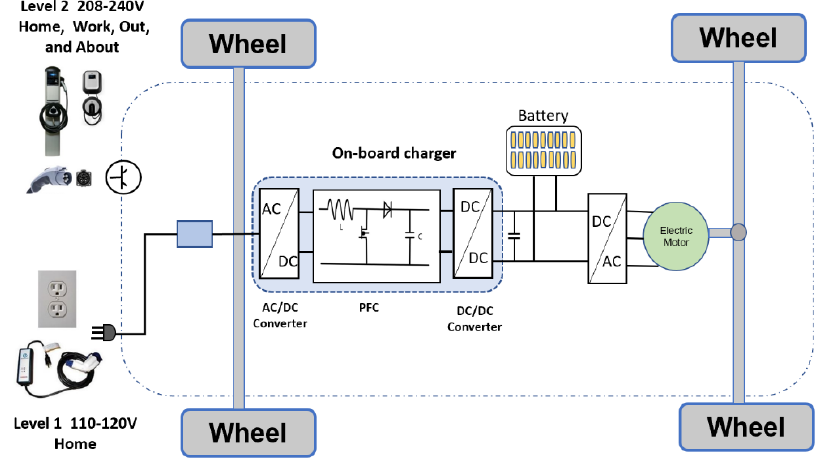
Figure 5. The basic layout of an on-board battery charger.